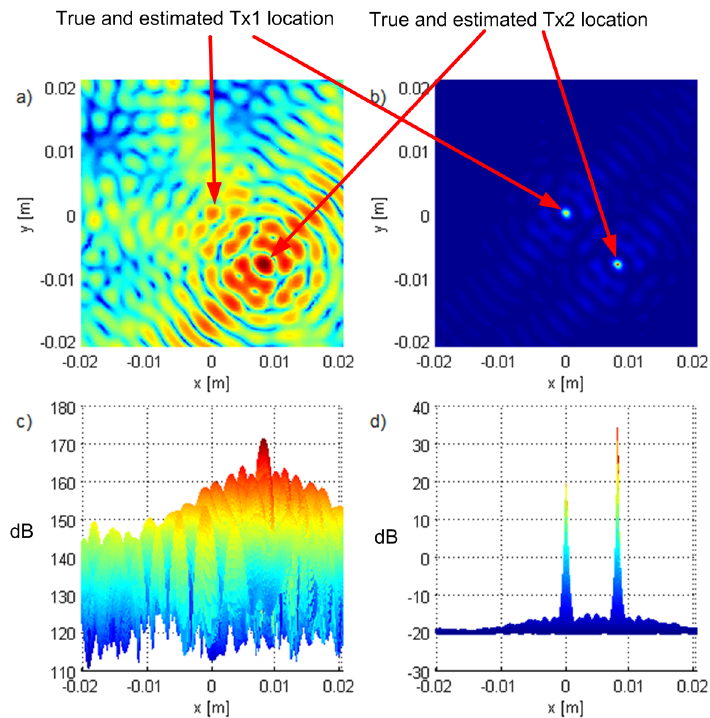
Figure 18. Experiments with two transmitters in LoS with a 10-dB difference in powers: top views of the criterion functions for G 90 and T 1 for ( a ) ML-US, ( b ) SCM-MUSIC, and the corresponding side views in ( c , d ) with the magnitude in dB.